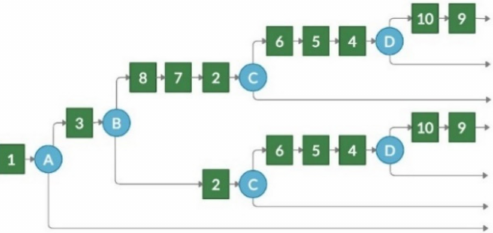
Figure A3. Result of modified contextual graph transformation to a tree structure for graph, presented in Figure